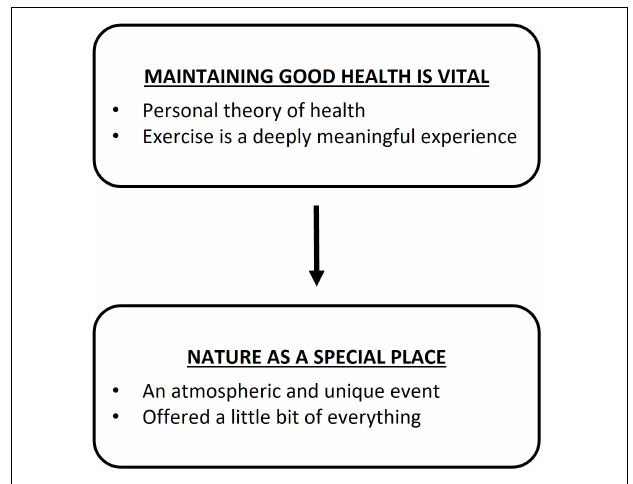
FIGURE 1 | Thematic map of superordinate